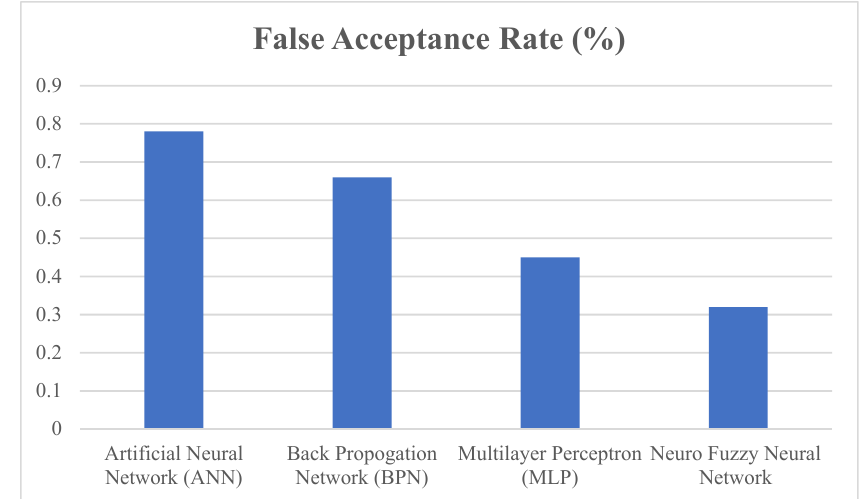
Figure 9. FAR calculation for various classifiers.